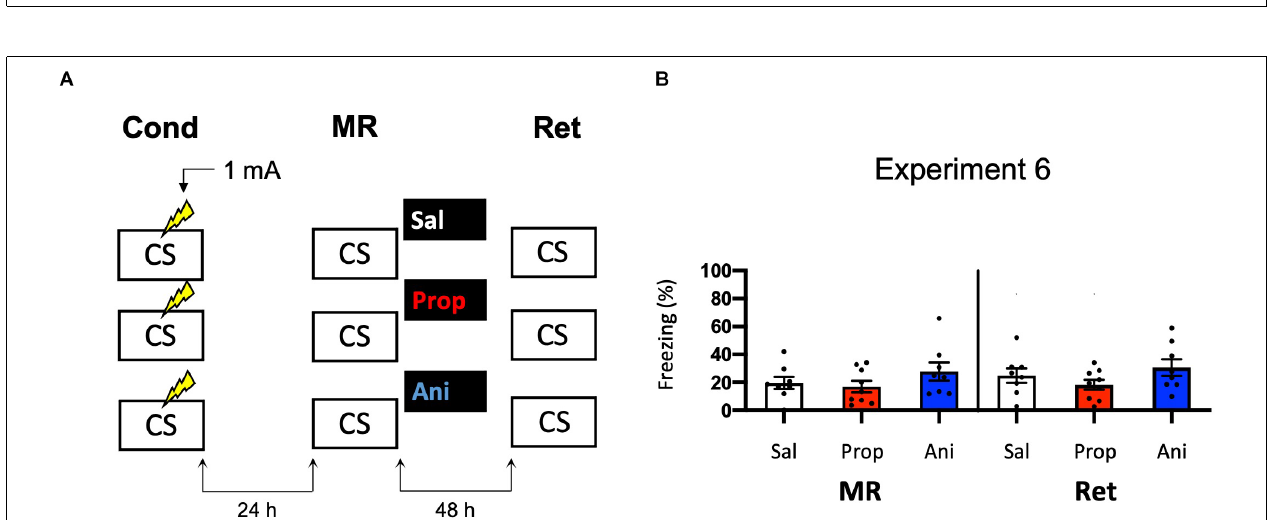
FIGURE 6 | No effect of propranolol or anisomycin on reactivated memories that were acquired with a single 1 mA shock during contextual fear conditioning. (A) Design of Experiment 6. Mice received one 1 mA shock during fear conditioning. One day later, mice received saline ( n = 8), propranolol ( n = 9), or anisomycin ( n = 8) after memory reactivation. Forty-eight hours afterward, retention of contextual fear was assessed. Cond, conditioning; MR, memory reactivation; Ret, retention; CS, conditioned stimulus (context); Sal, saline; Prop, propranolol; Ani, anisomycin. (B) Results of Experiment 6. Average percentage of freezing during memory reactivation is displayed on the left, and freezing during the retention test on the right panel of the column chart (saline in white bars, propranolol in red bars, and anisomycin in blue bars). Error bars represent SEM. Filled circles indicate individual